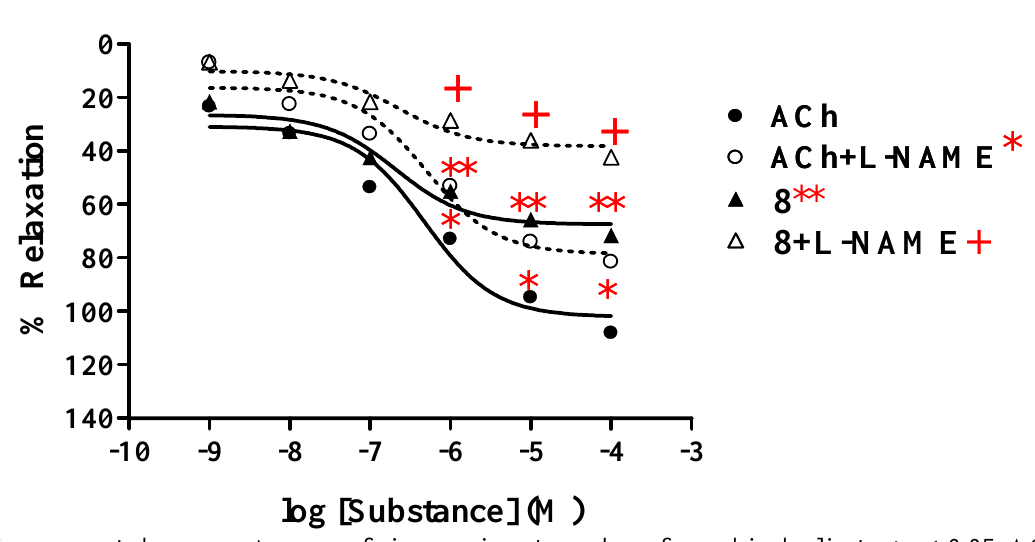
Figure 5. Effect of 8 on the vascular function of rat thoracic aorta in the presence of L -NAME (1 mM) compared with ACh.